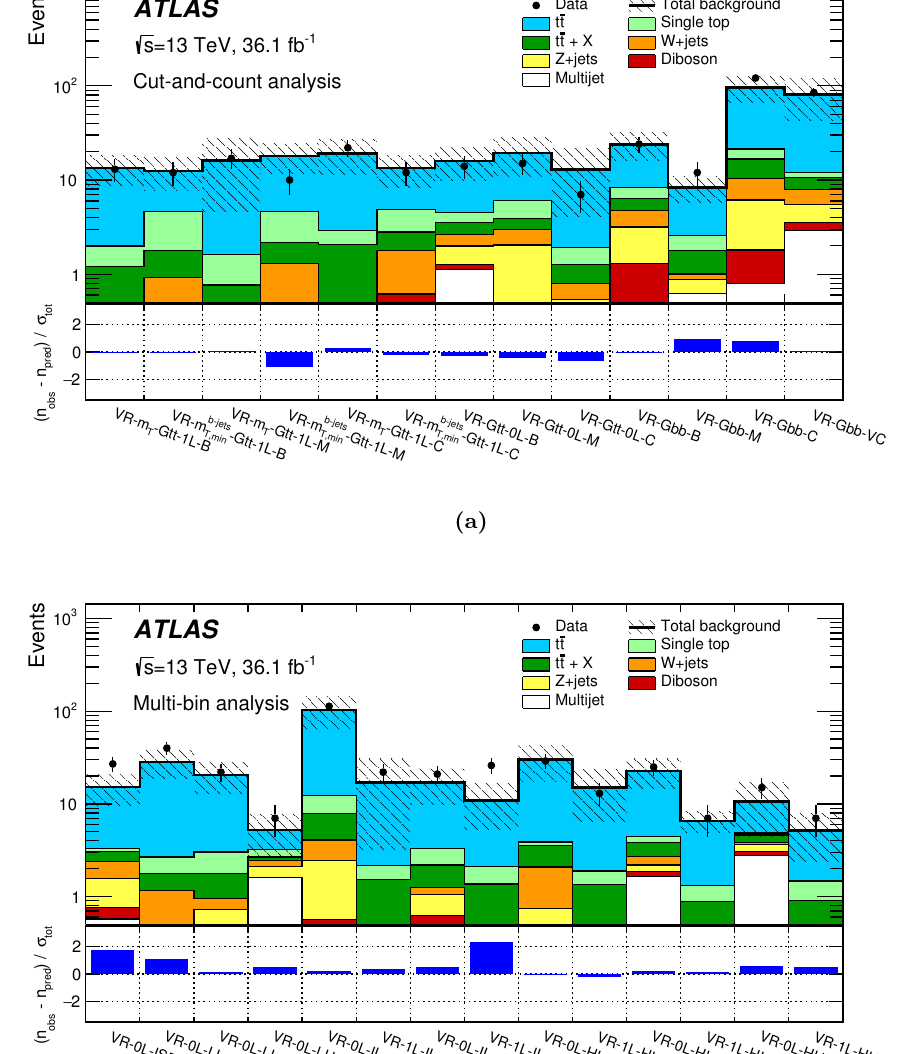
Figure 8. Results of the background-only (cid:12)t extrapolated to the VRs of (a) the cut-and-count and (b) the multi-bin analyses. The t (cid:22) t normalisation is obtained from the (cid:12)t to the CRs shown in (cid:12)gure 7. The upper panel shows the observed number of events and the predicted background yield. All uncertainties de(cid:12)ned in section 7 are included in the uncertainty band. The background category t (cid:22) t + X includes t (cid:22) tW=Z , t (cid:22) tH and t (cid:22) tt (cid:22) t events. The lower panel shows the pulls in each